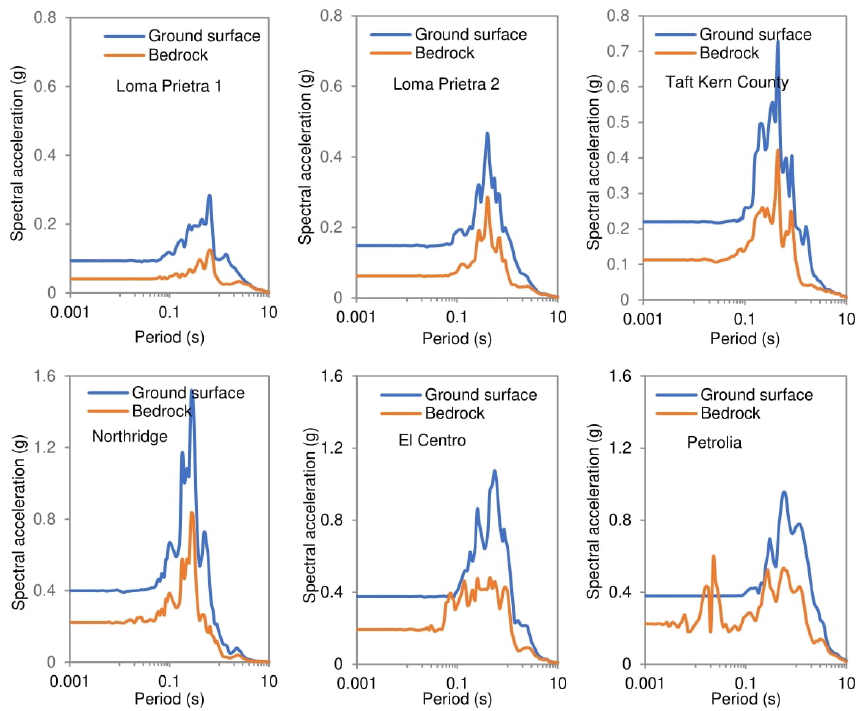
Figure 8. Typical spectral acceleration of bedrock and ground surface motion at Toorsa II in Zone I corresponding to the respective input motions.